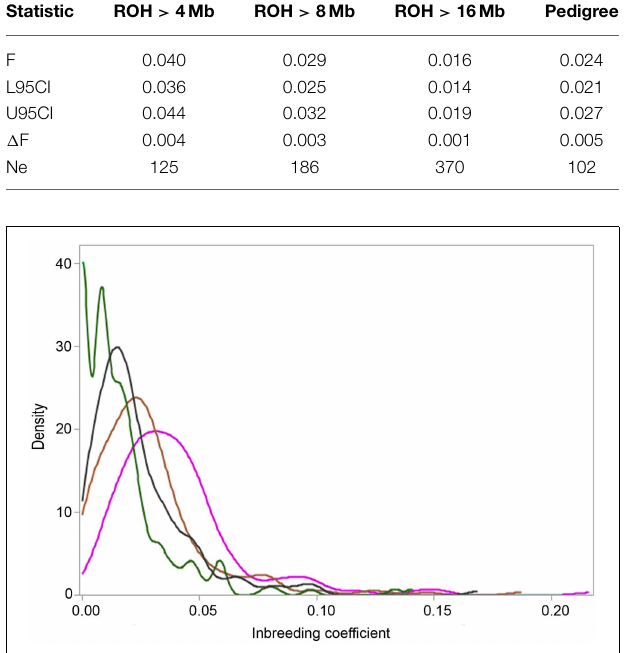
FIGURE 5 | Distributions of three ROH ( F ROH > 4Mb in magenta; F ROH > 8Mb in brown and F ROH > 16Mb in green) and one pedigree ( F PED in black) inbreeding coefficients for the Tyrol Grey cattle.